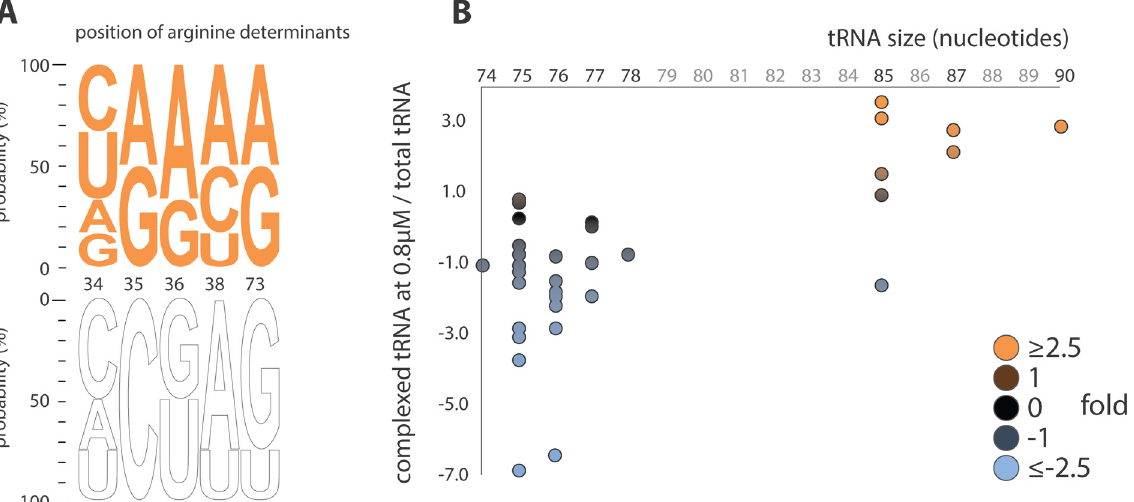
Fig 6. tRNA features versus apparent affinity for yArgRS. (A) Sequence logo comparing the identity elements in yeast tRNA Arg (white, outlined letters) with the nucleotides at the corresponding positions in non-cognate tRNA species displaying apparent high affinity for yArgRS (top 6 tRNAs at 0.8 μ M in Fig 4). (B) Association of tRNA sizes to apparent affinity for yArgRS. The color code corresponds to the relative abundance of each tRNA species at 0.8 μ M (Fig 4, first column).